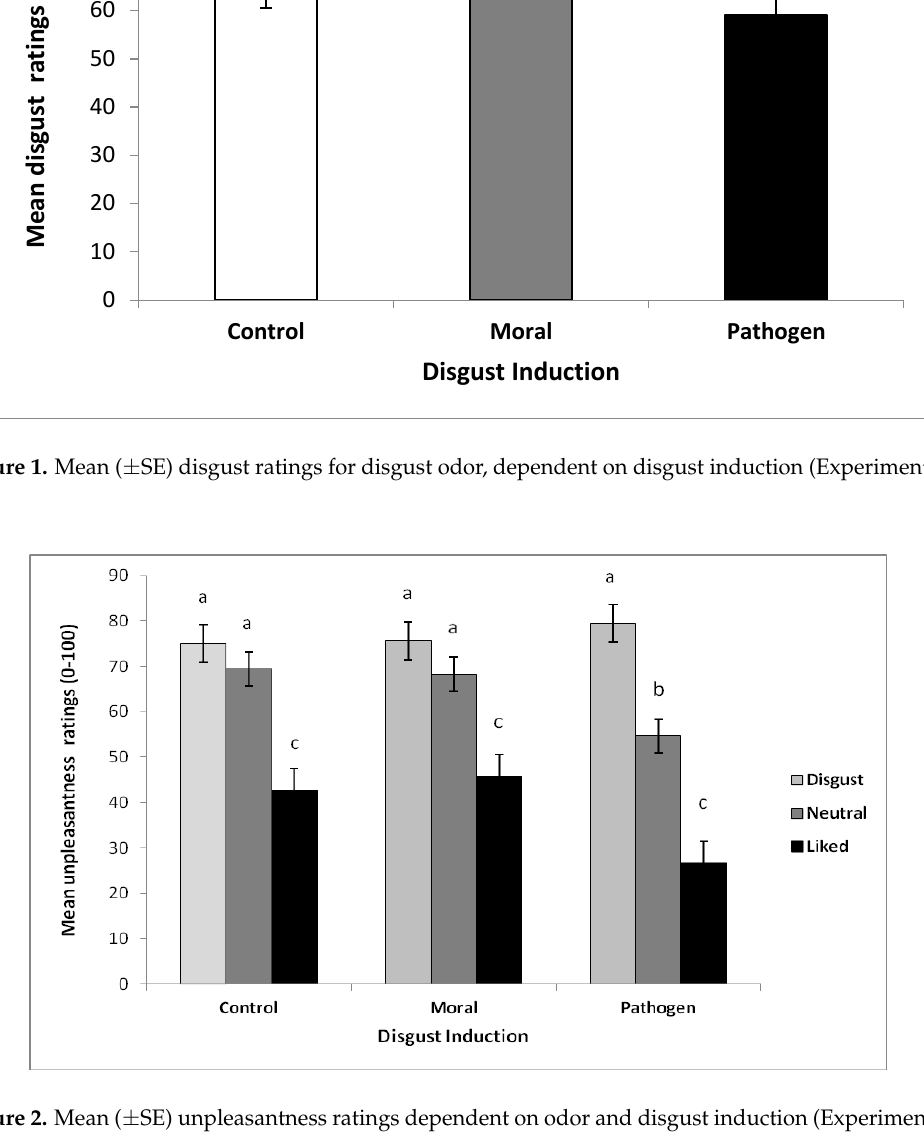
Figure 2. Mean (±SE) unpleasantness ratings dependent on odor and disgust induction (Experiment 1). Note: Letters refer to analyses within each induction group, where mean values denoted by different letters are significantly different from each other: p < 0.001.